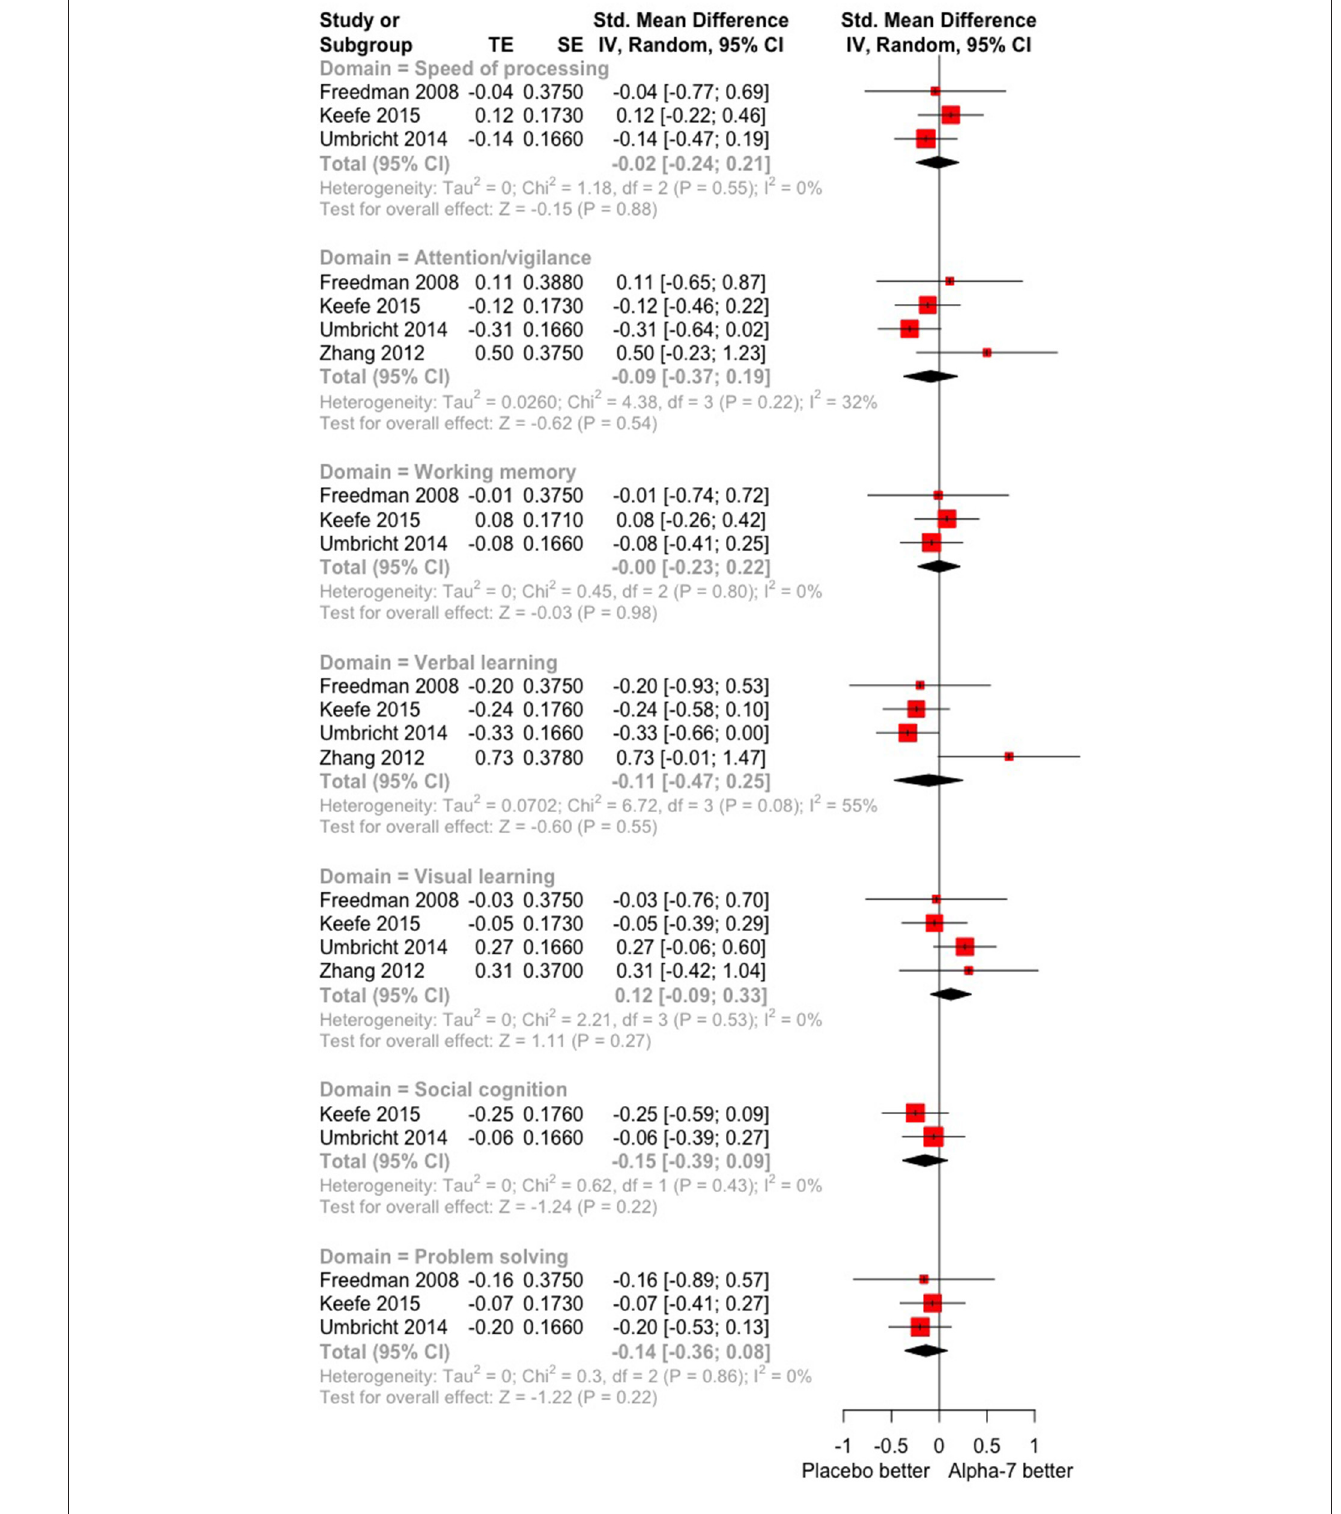
FIGURE 3 | Overall efficacy by cognitive domain of antipsychotic drug plus α -7 nAChR agonists vs. antipsychotic drug plus placebo.